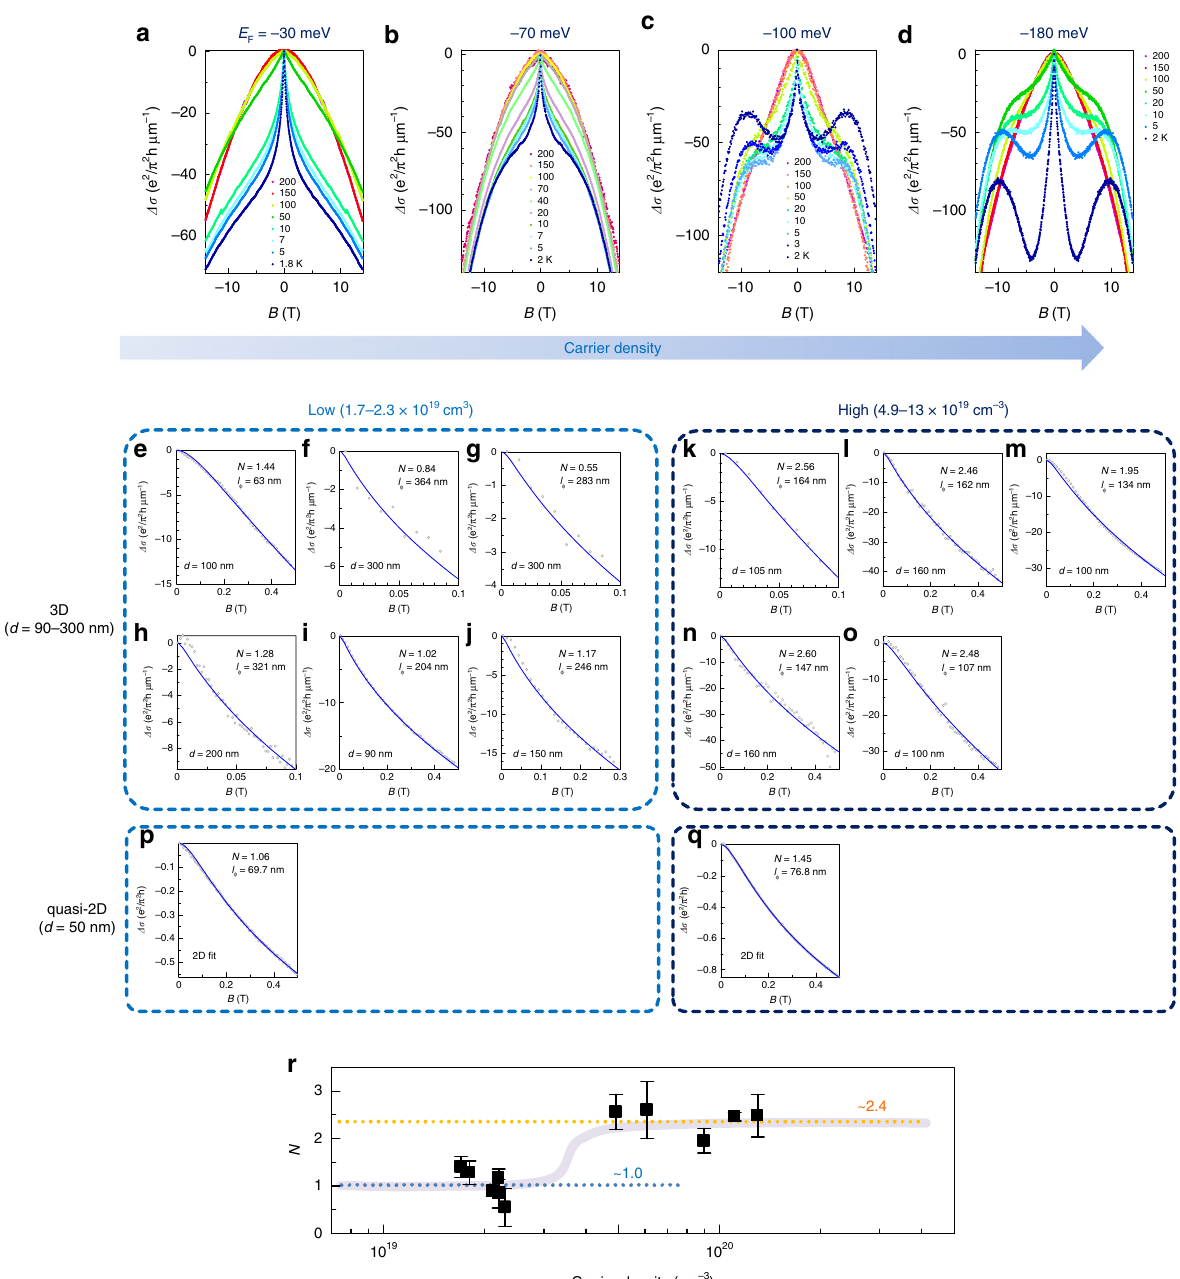
Fig. 4 Carrier density evolution of the magnetoconductance in Sr 3 SnO thin fi lms. a – d Wide- fi eld ( ∣ B ∣ < 14 T) MC for four samples with different carrier densities. The Fermi energy estimated from the carrier density (see text) is shown for each graph. Magnetic fi eld orientations are a B ⊥ I and b – d B ∥ I . Low- fi eld MC for 3D fi lms in the e – j low carrier density regime and k – q high carrier density regime. Experimental data are shown in open circles, whereas theoretical fi ts are shown in solid lines. Each panel represents a different sample. p , q Low- fi eld MC for quasi-2D fi lms ( B ⊥ I ), in which the theoretical fi ts are performed based on a 2D (HLN) formula. r The number of channels ( N ) as a function of carrier density. The average value of N for the two different N regimes are shown accompanied with dotted lines. The gray line is a guide to the eye. The error bars represent standard deviation. Source Data are provided as a Source Data fi dominated by electron – electron interactions and p = 1. From Hall carrier density of n p = 1.8 × 10 19 cm − 3 . The temperature Fig. 6, it can be seen that l ϕ increases with decreasing T , with dependence of l ϕ in general re fl ects the dephasing due to inelastic scattering. Theoretically, it follows l ϕ ∝ T − p ∕ 2 ( τ ϕ ∝ T − p ), where p exponents − 0.75 ( p = 3/2) and − 0.5 ( p = 1) for 3D and quasi- depends on the dephasing mechanism 46,47 . In three dimensions, 2D fi lms, respectively. This suggests that electron – electron p = 3/2 for electron – electron interactions and p = 3 for interactions could be a dominant dephasing mechanism in both electron – phonon interactions 46,47 . However, note that the latter is cases, although we note that dephasing due to electron – phonon for a clean limit, and for a disordered system, predicted values of interactions in a disordered 3D system is not well understood 48 . Below 5 K, there is a change in exponent, followed by a possible p ranges from 2 to 4 48 . In 2D, dephasing at low temperatures is